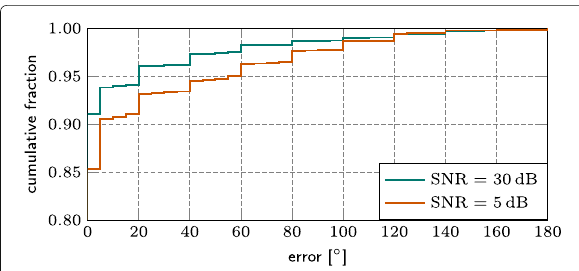
Fig. 9 Normalized cumulative histogram of the absolute DOA estimation error. Integer multiples of 20 ◦ are more common because of our setup, where only angles ϕ ∈ { 0 ◦ ,20 ◦ , ... ,180 ◦ } are available for the true source